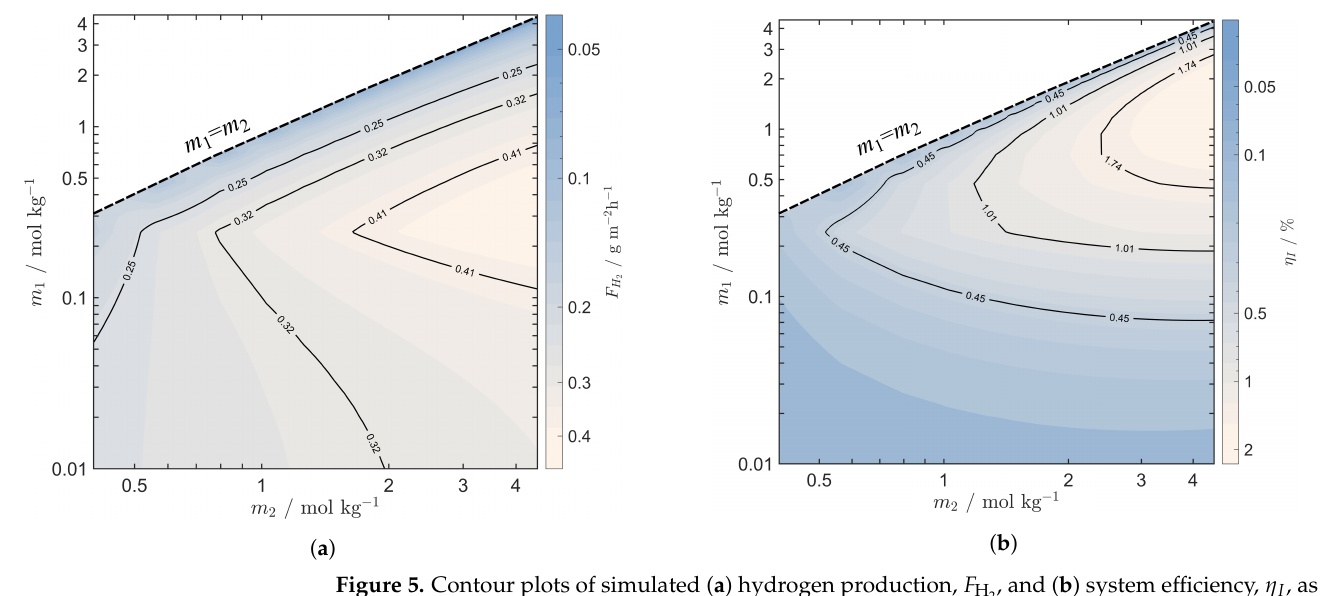
, and ( b ) system efficiency, η I , as 2